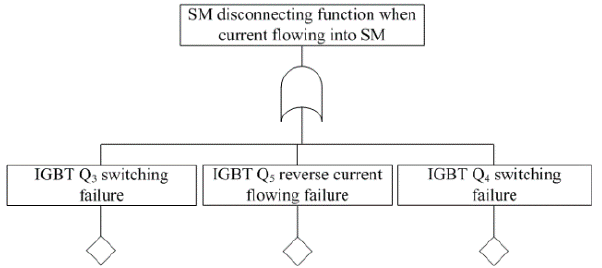
Figure 13. Sub fault tree for SM disconnecting function when current flowing into SM.